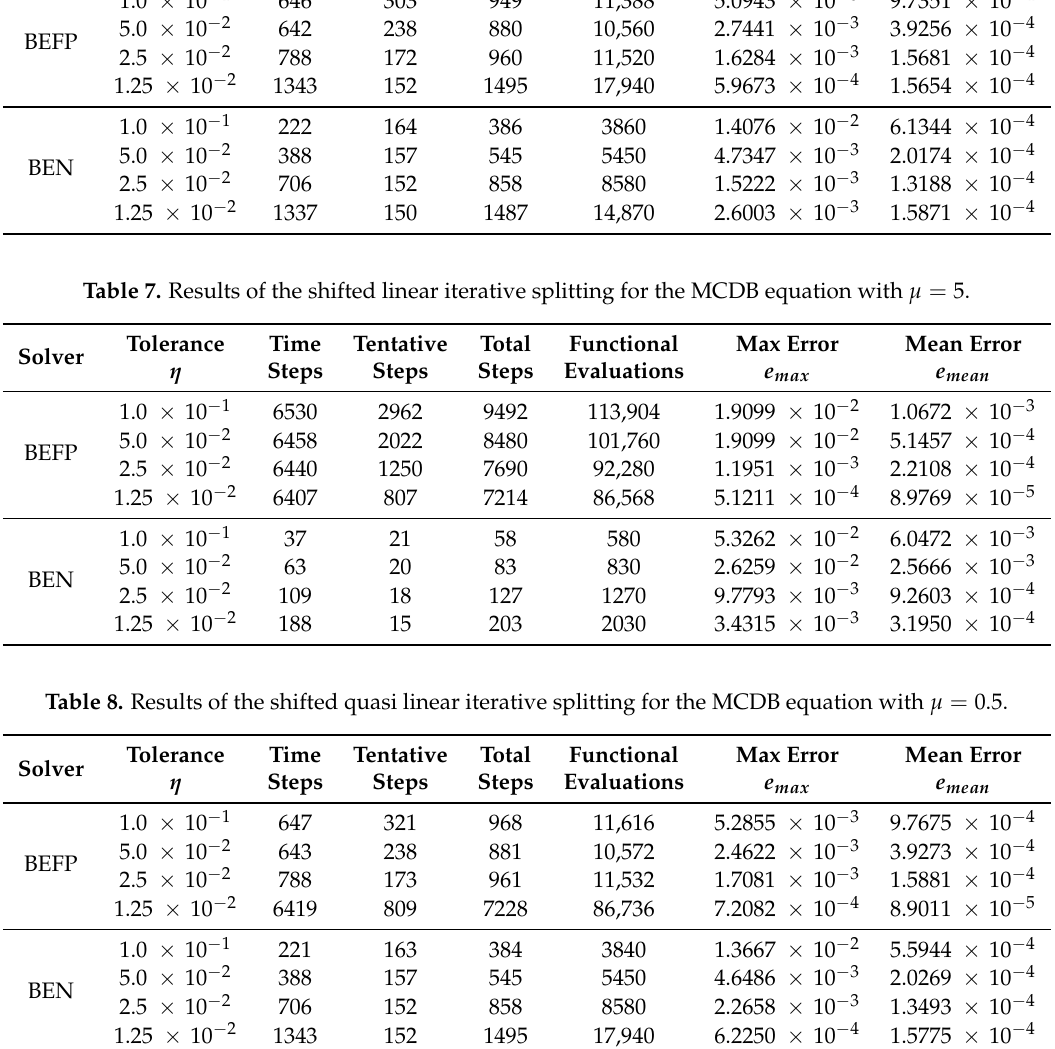
Table 6. Results of the shifted linear iterative splitting for the MCDB equation with µ = 0.5. Solver